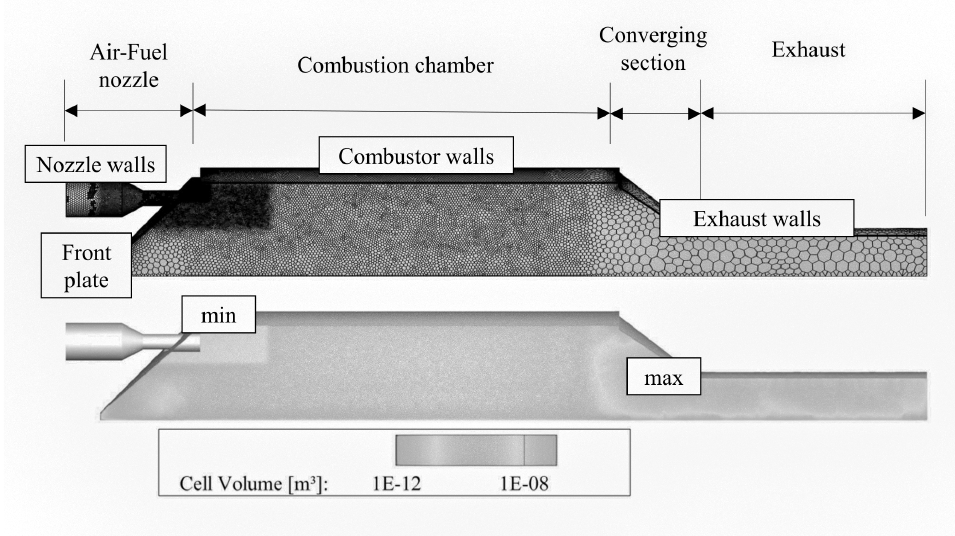
Figure 5. Grid and computational domain of the numerical CFD